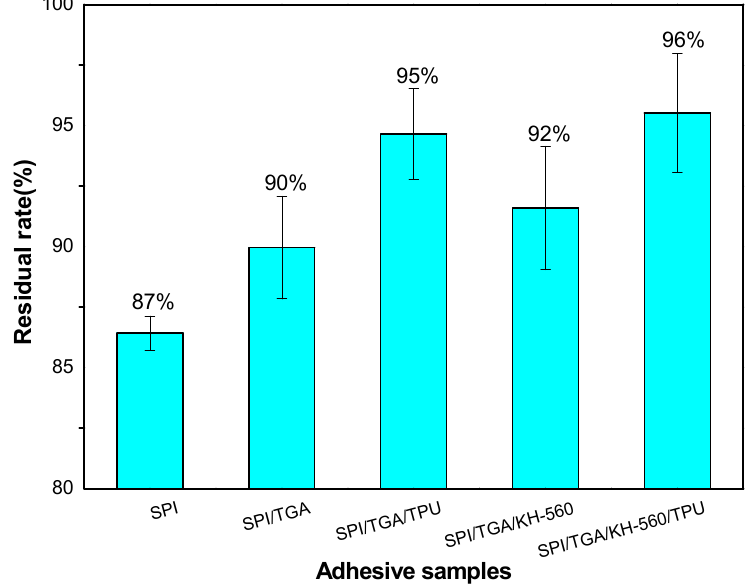
Figure 5. Non hydrolysable portion of different cured adhesives.